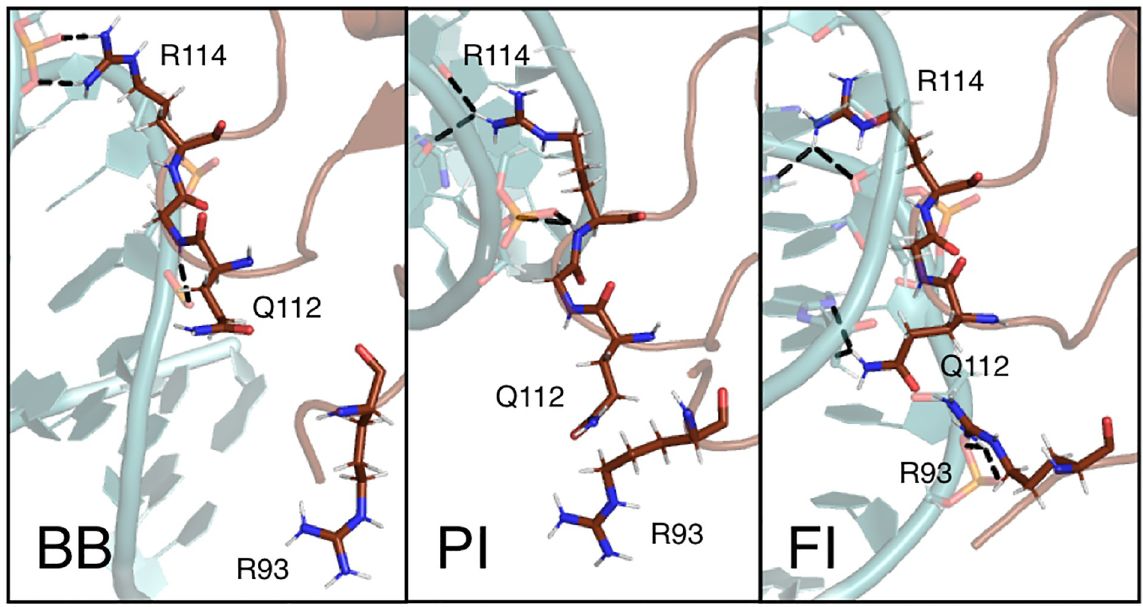
Fig 3. Snapshots of the modes of interaction between H-NS and DNA. The protein (brown) and DNA (light blue) are shown in cartoon representation. The QGR motif and R93 are shown as sticks. The labels indicate the different binding modes: (BB) Backbone bound, (PI) Partial insertion and (FI) full